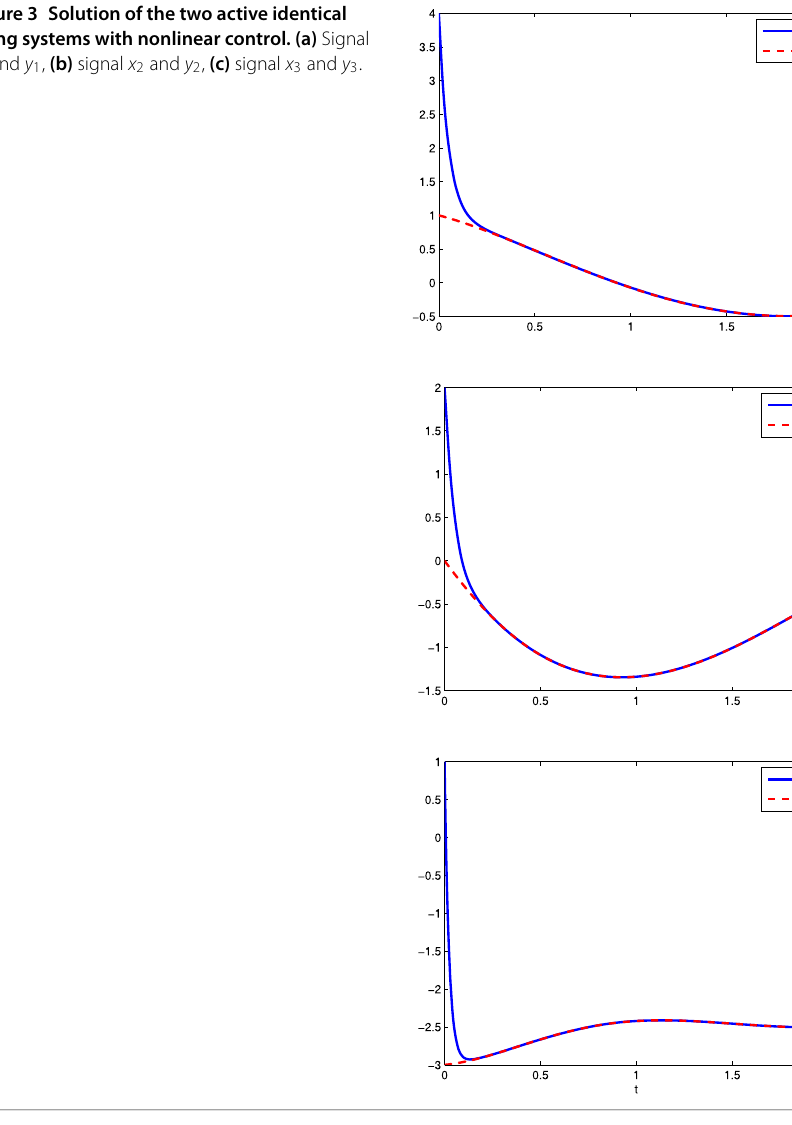
Figure 3 Solution of the two active identical Wang systems with nonlinear control. (a)